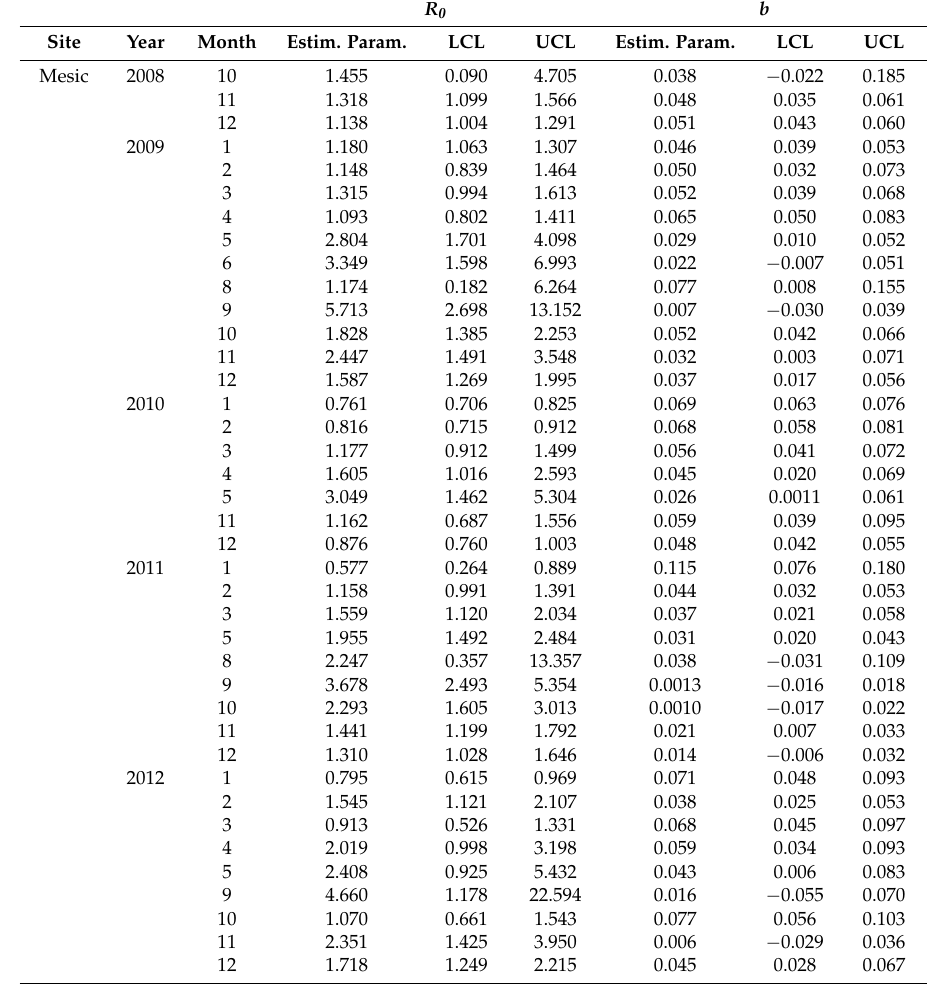
Distribution of parameters from nighttime net ecosystem exchange (NEE night ) bootstrap simulations. R 0